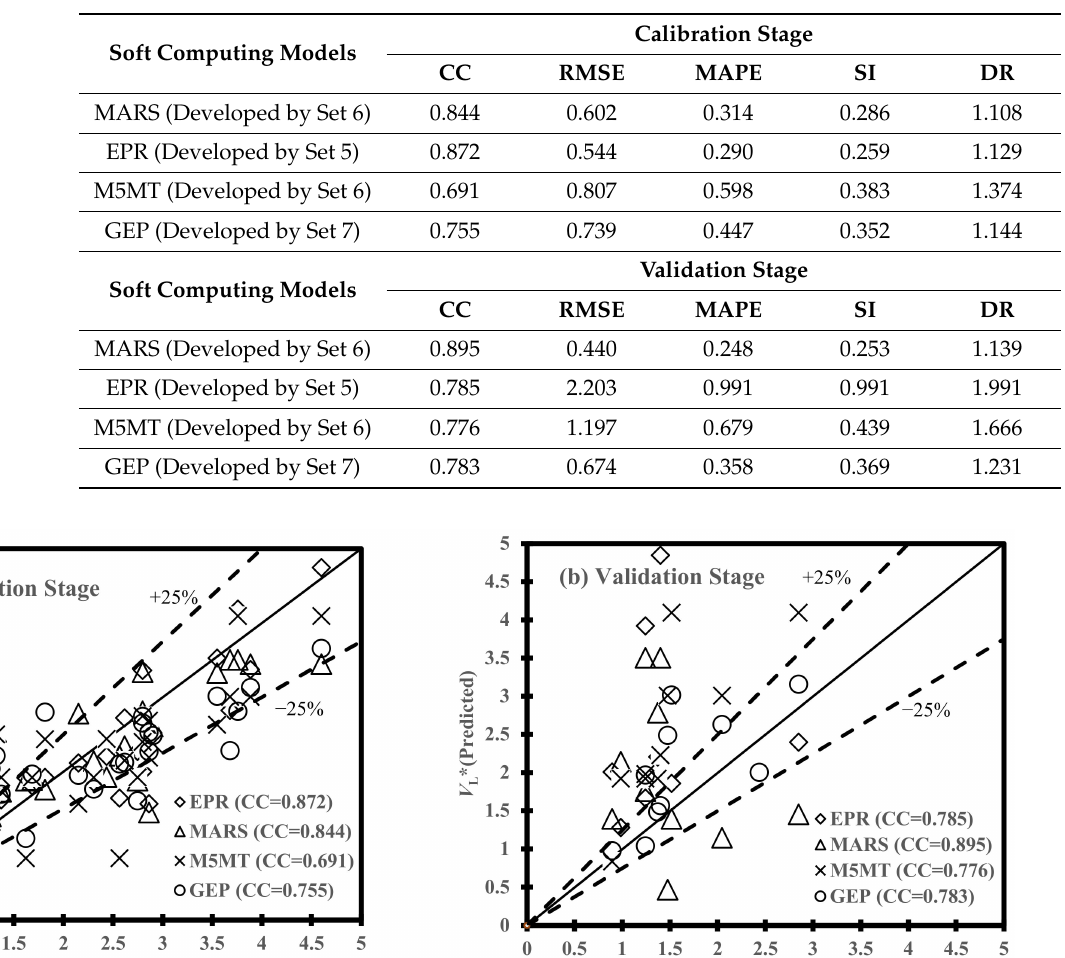
Table 14. The best statistical performances of the soft computing models for prediction of V L *.